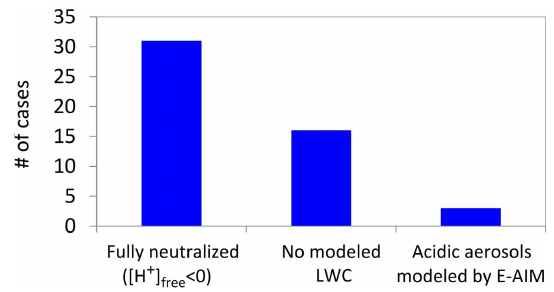
Fig. 9. E-AIM II modeling: in situ aerosol pH can only be calcu- Figure 9. E-AIM II modeling : in situ aerosol pH can only be calculated in very few cases (3 out 695 lated in very few cases (3 out of 50) in our samples. A total 31 of 50) in our samples. 31 aerosol samples were calculated as fully neutralized ([H + ] free < 0) that 696 aerosol samples were calculated as fully neutralized ([H + ] free < 0) could not be modeled by E-AIM II. 16 samples were shown as no modeled LWC. 697 that could not be modeled by E-AIM II. Altogether, 16 samples were shown as no modeled LWC.